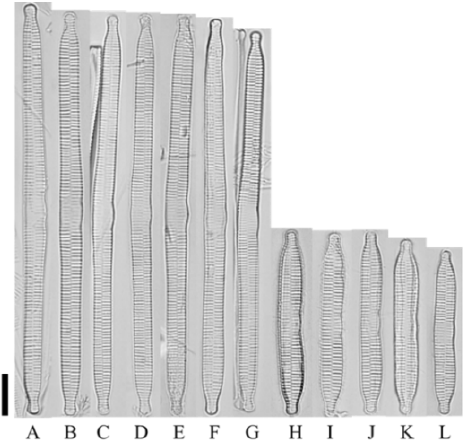
Figure 2. Light microscope photo of Hannaea librata sp. nov. ( A – L ) valve view. ( A – G ) taken from isotype population (AG9002); ( H – L ) from holotype population (AG001); scale bar = 10 µm.